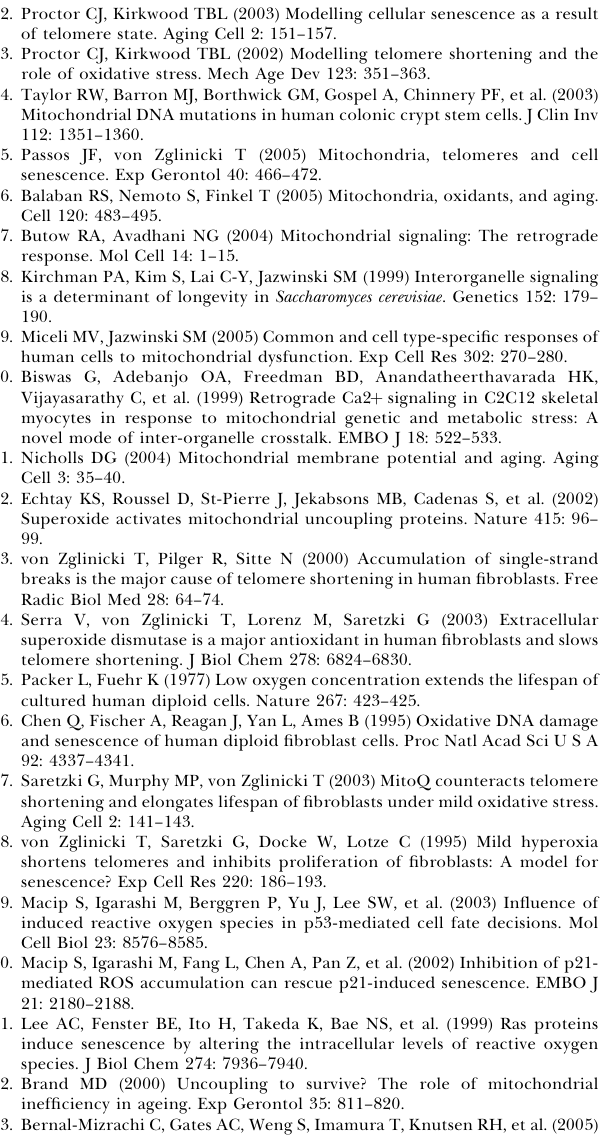
Figure S6: Correlation between Cellular ROS Levels and Telomere Shortening Rates in Human Fibroblasts ROS levels were varied in three human fibroblast strains (P43, upward triangles; P100, downward triangles; and MRC5, circles) by growing cells until senescence under either normoxia (filled symbols), hyper- oxia (open symbols), hypoxia (red symbols), or hypoxia plus addition of 400 l M a -phenyl-butyl-nitrone (PBN), a free radical scavenger (pink symbols). MRC5 cells were not grown under hypoxia, but were treated with 250 l M DNP (green symbol) or were transfected with an SOD3 transgene [34] (yellow symbol) instead. Cytoplasmic peroxide levels were measured by DHR flow cytometry. DNA samples were taken every 2–3 PD (a total of between three and 14 samples per strain and condition), and telomere length was measured by in-gel hybridisation and (for P100 cells) by real-time PCR. Measurements were performed in quadruplicate gels or PCRs, and telomere shortening rates were calculated by linear regression. Data are mean